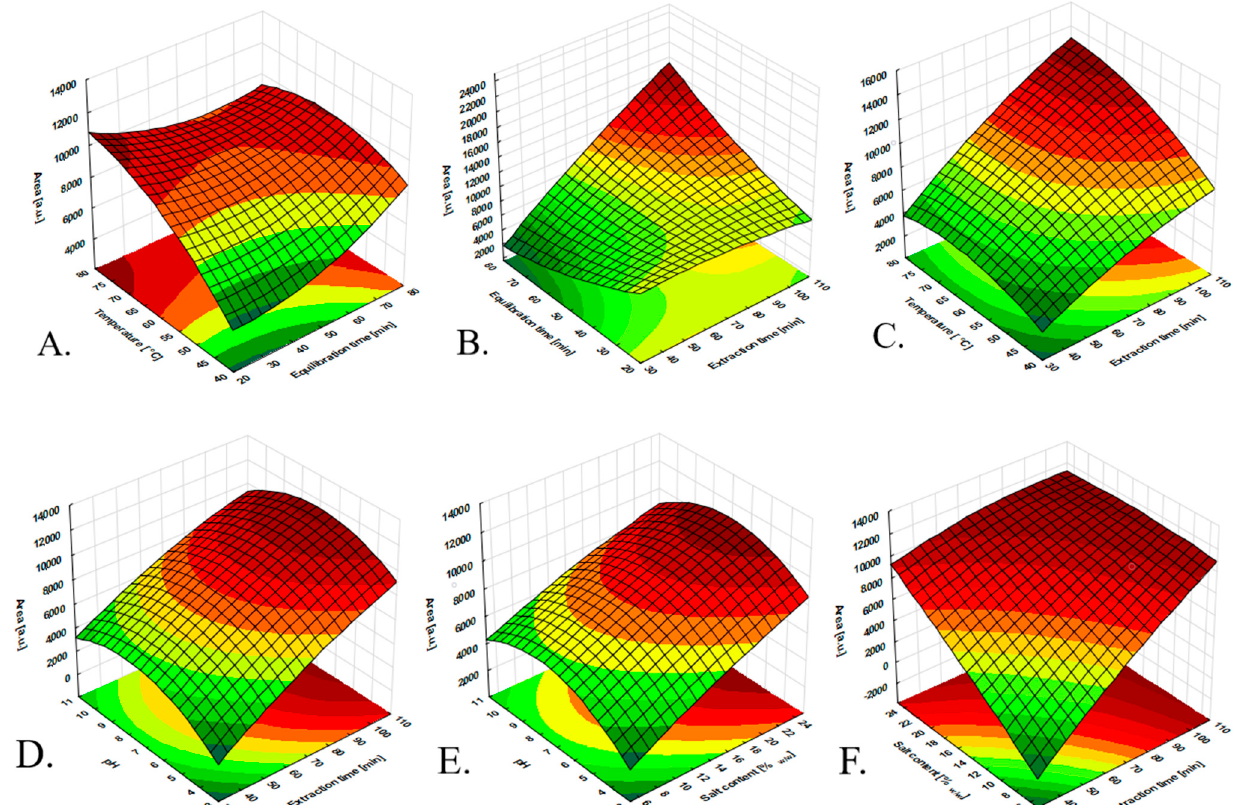
Figure 5. Statistical significance of the effects of the extraction parameters on the extraction performance of the IL-based fiber: ( A ) response surfaces as functions of extraction temperature vs. equilibration time; ( B ) response surfaces as functions of equilibration time vs. extraction time; ( C ) response surfaces as functions of temperature vs. extraction time; ( D ) response surfaces as functions of pH vs. extraction time; ( E ) response surfaces as functions of pH vs. salt content; ( F ) response surfaces as functions of salt content vs. extraction time.